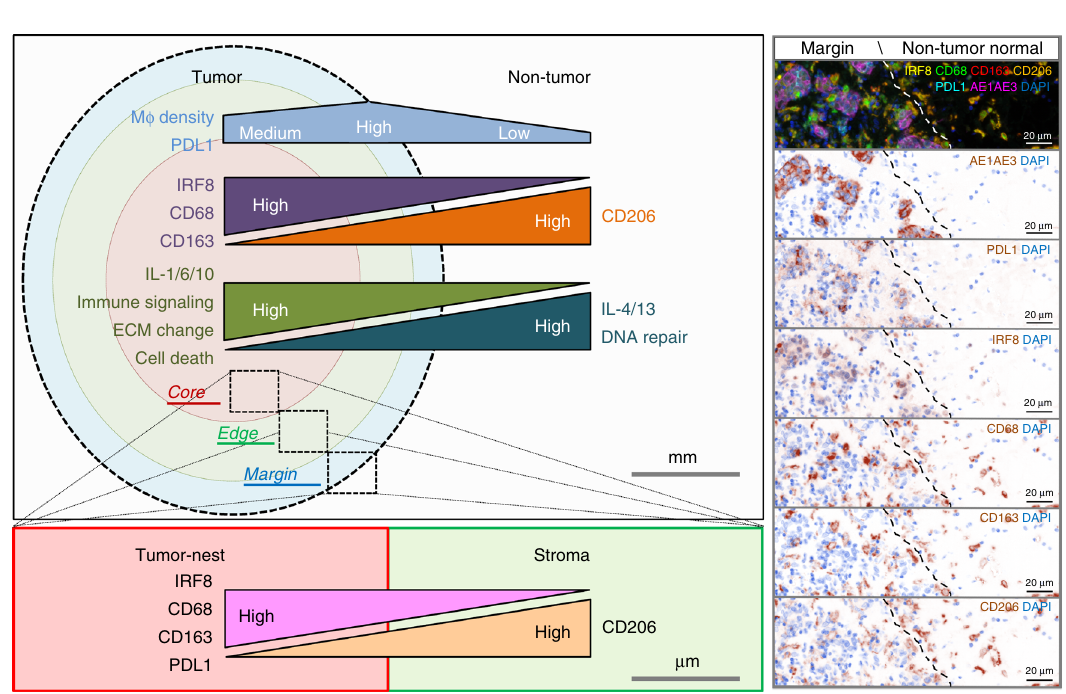
Fig. 7 Schematic model of spatial macrophage heterogeneity in anatomic regions in gastric cancer. A proposed model suggesting that TAM density and marker expression varies between GC sample regions. Distinct marker expression pro fi les on TAMs were associated with their population disparity between the tumor site and non-tumor tissue and between the tumor-nest and stroma. TAM populations were associated with signature pathways which may help inform of their function and polarization status. Similar trend of marker changes on TAMs were observed between the tumor-nest and stromal compartments within different tumor regions (core, edge, or margin). M ϕ : macrophage. ECM: extra-cellular